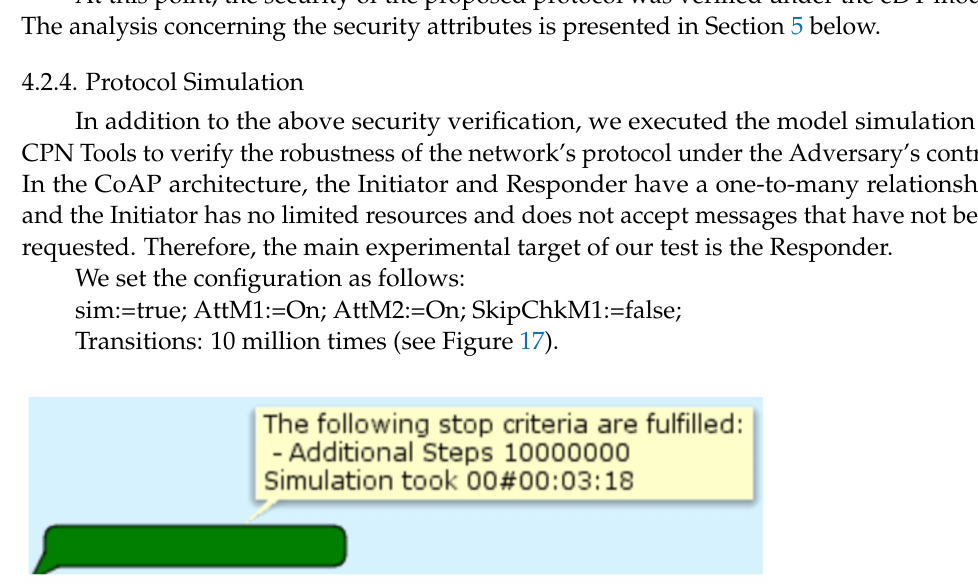
Figure 17. Completion of simulation notice in CPN